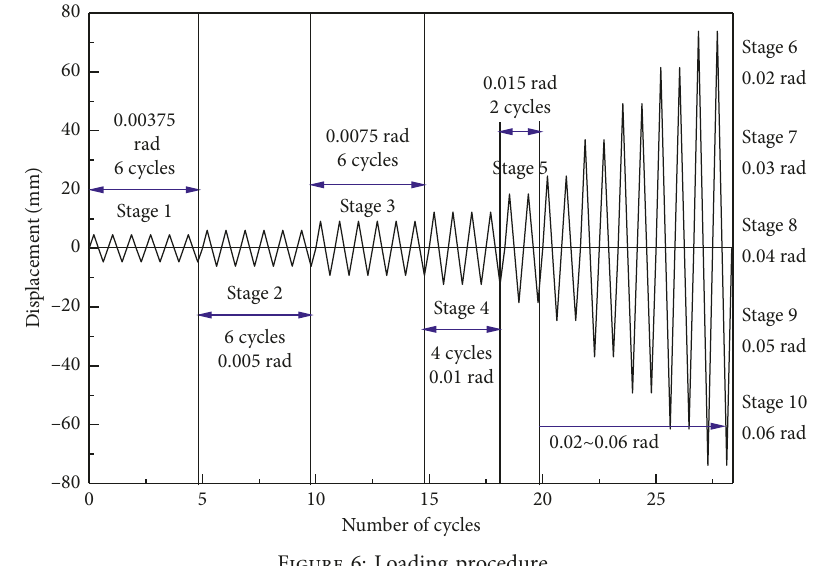
Figure 6: Loading procedure.